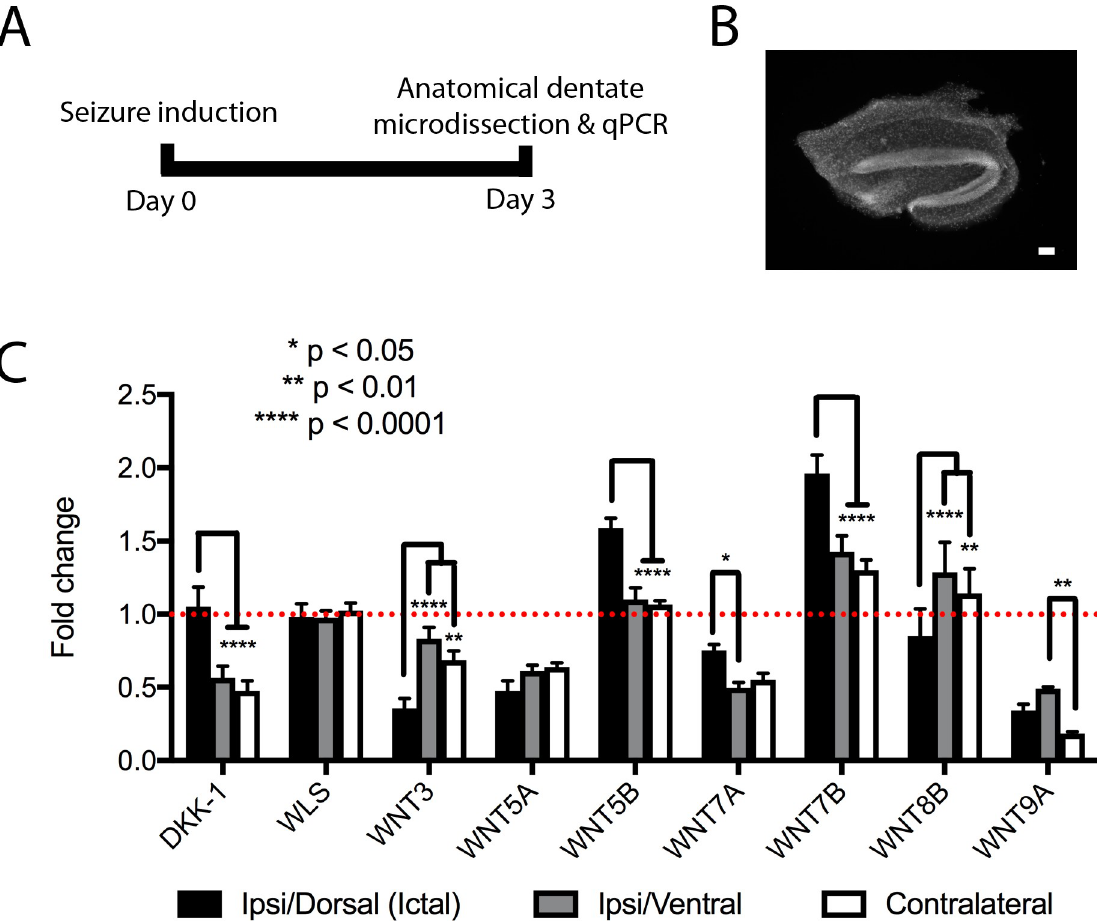
Fig 6. Transcriptional profiling of the whole dentate gyrus 3 days after seizure induction. (A) Timeline of transcriptional analysis. (B) Image of a representative DAPI-labeled cross-section of micro-dissected dentate gyrus used for transcriptional analysis. Scale bar 100 μ m. (C) Relative Wnt pathway gene transcription in the ictal and peri-ictal regions 3d after seizure induction. Various patterns are observed, whereby certain genes are selectively upregulated in the ictal zone (Wnt5b and Wnt7b), selectively downregulated in ictal (Wnt3) or peri- ictal regions (Dkk-1), or relatively unchanged from baseline (WLS, Wnt8b).